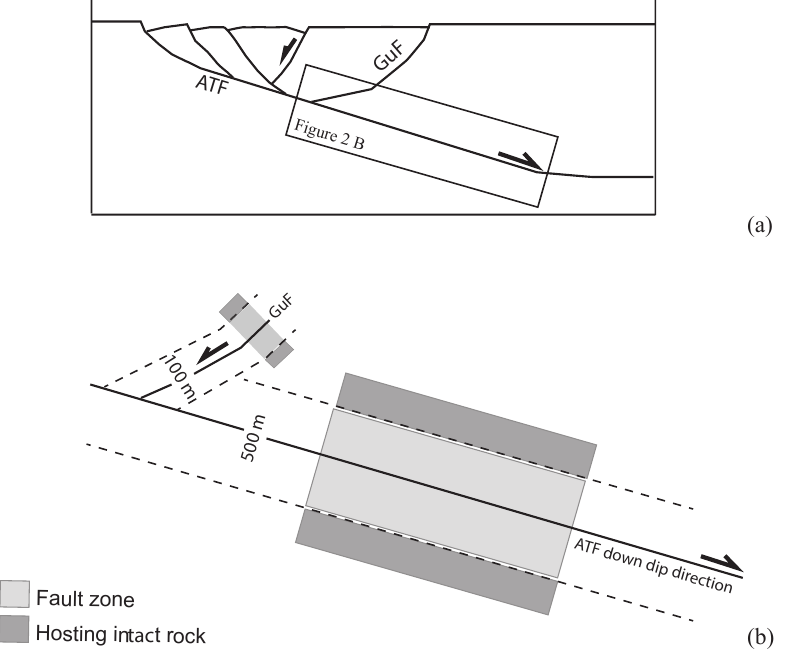
Figure 2. (a) Illustration of the ATF system highlighting the ATF and GuF fault segments. Rectangle showing the zoomed area of (b) . (b) Sketch of the ATF and GuF faults zones where different fault mechanical behaviours are modelled using different Young modulus parameters and fault zone thickness (see text for